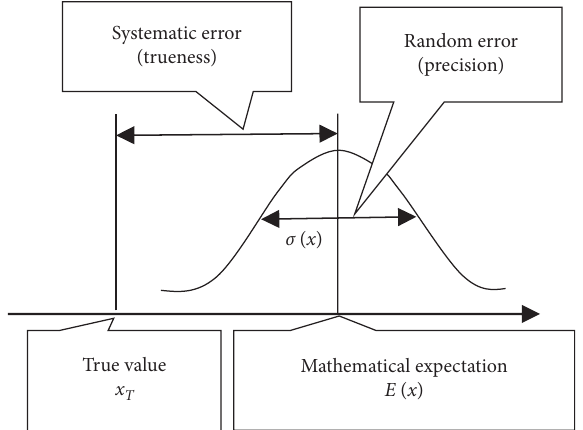
Figure 1: Schematic diagram in traditional measurement